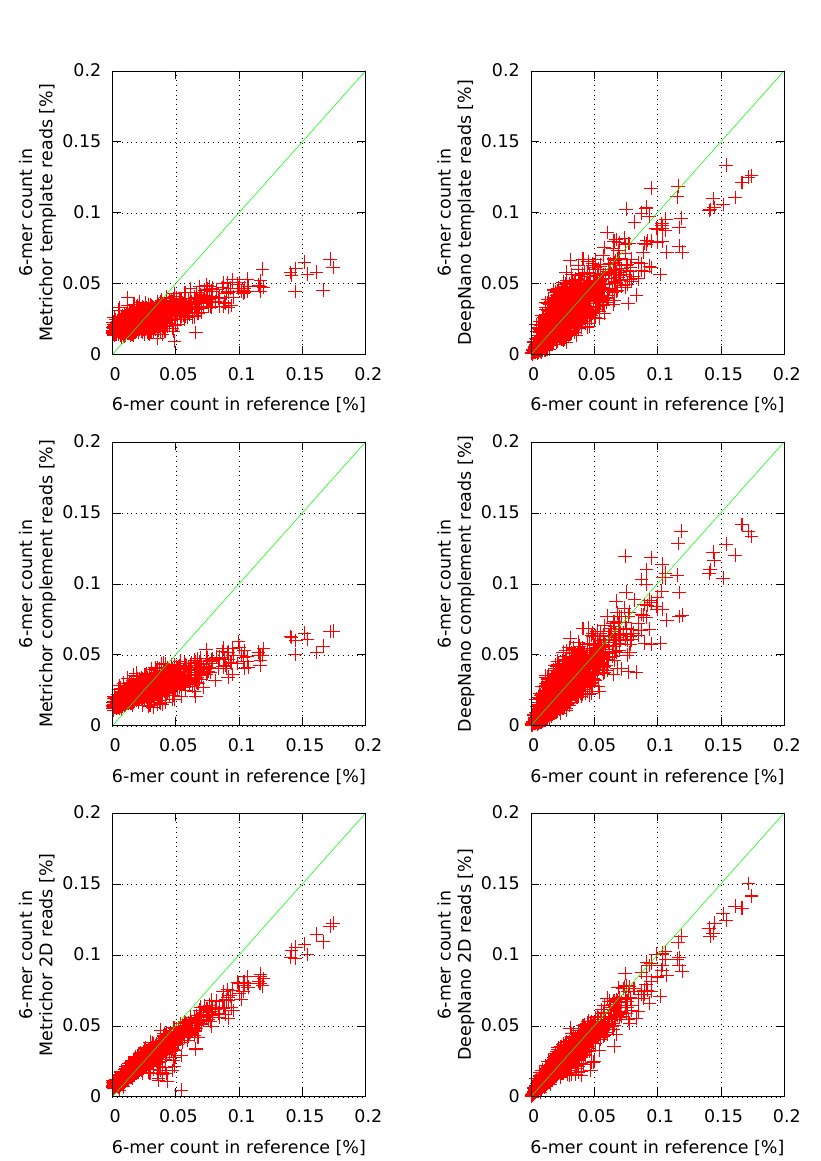
Fig 3. DeepNano reduces bias in 6-mer composition. Comparison of 6-mer content in Klebsiella reference genomeand base-called reads by Metrichor (left) and DeepNano(right). From top to bottom: template, complement,